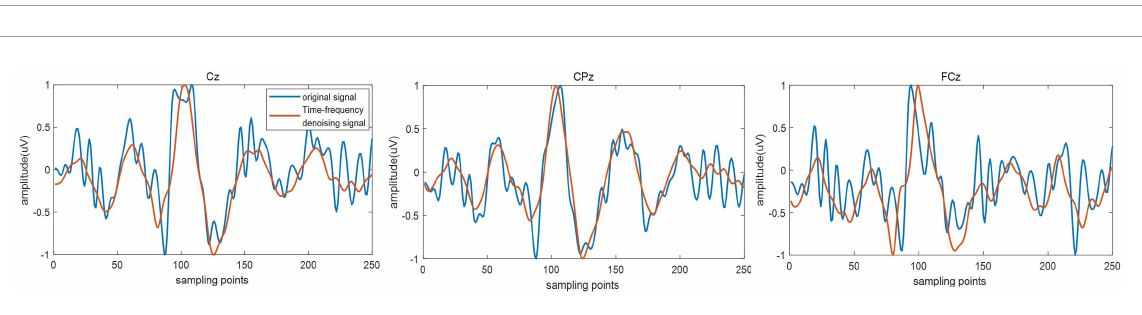
FIGURE5 The original single trail signal and the signal after